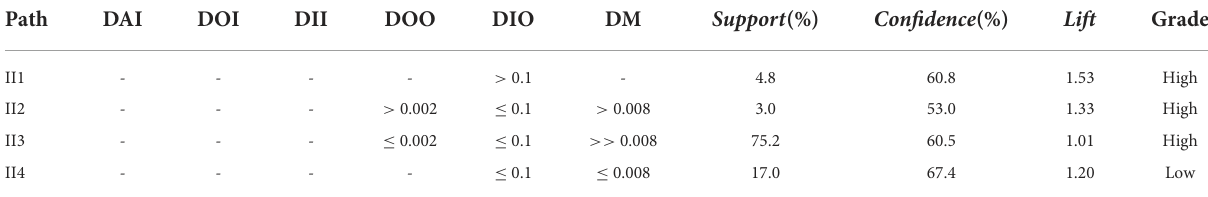
TABLE 4 Green innovation performance (GIP) decision rule table for general digitalization enterprises.